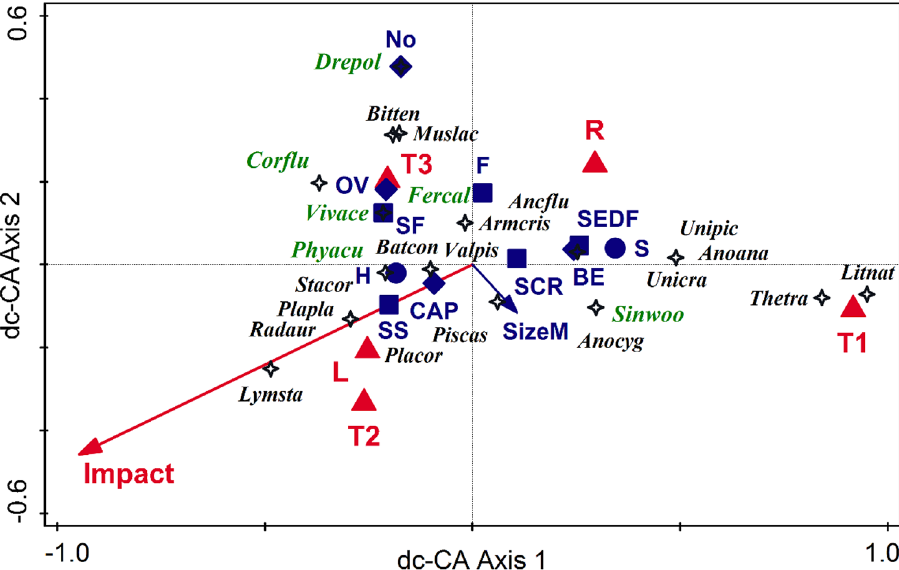
Figure 2. Double-constrained correspondence analysis (dc-CA) with selected predictors on presence-absence data in T1–T3. The selected functional traits (in blue) are Sexes (circles: H—hermaphrodite, S—separate sexes), Feeding type (squares: SCR—scraper, SS—scraper and sediment, SF—scraper and filter, F—filter, SEDF—suspension and deposit feeder), Oviposition (diamonds: OV—ovo-viviparity, CAP—capsule/eggmass, BE—parental care, juveniles in brood pouches of demibranchs, No—no oviposition, external fecundation), and mean body size (SizeM); the selected environmental predictors (in red) are time (Period, with levels T1—XIXth century, T2—1995–2000, T3—2020), habitat (R—river, lotic sector; L—lake, a lentic sector in reservoirs) and human impact (Impact). Species are coded by the first three letters of the genus and species names. The adjusted explained variation was 16.47%, the first axis accounts for 12.7% and the second for 2.2%. Native species have black labels, while aliens (AIS) are written in green.